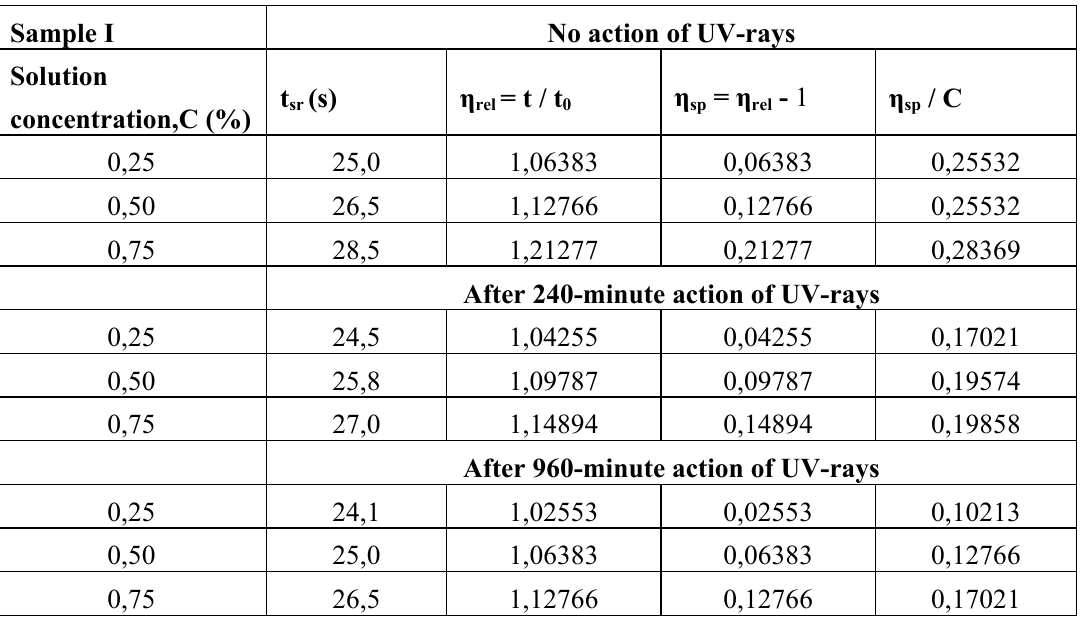
Table 4 . Viscosity values of nitrodope solution in acetone for sample I.